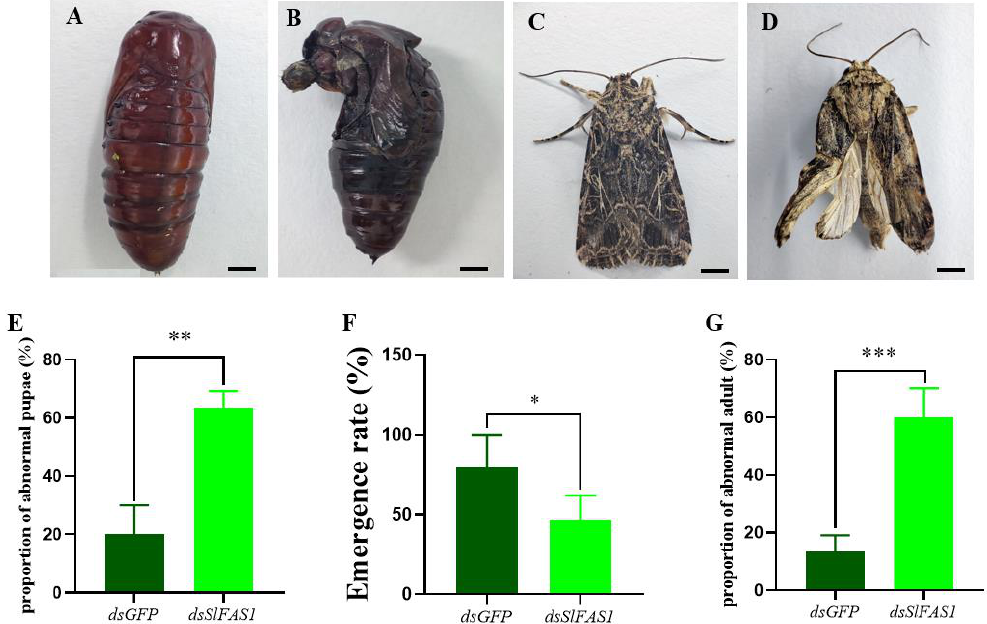
Figure 8. Morphology of pupae and adults after knocking down SlFAS1 in fifth instar S. litura . ( A ) Normal pupae after dsGFP injection. ( B ) Abnormal pupae after dsSlFAS1 injection. ( C ) Normal adults after dsGFP injection. ( D ) Abnormal adults after dsSlFAS1 injection. ( E ) Effect of silencing SlFAS1 on the proportion of abnormal pupae in S. litura . ( F ) Effect of silencing SlFAS1 on emergence rate in S. litura . ( G ) Effect of silencing SlFAS1 on the proportion of abnormal adults in S. litura . Significant differences were compared using a one-way analysis of variance (ANOVA). Significant differences were indicated by asterisks (* p < 0.05; ** p < 0.01; *** p < 0.001); scale bars in A and B: 2 mm; scale bars in C and D: 2 mm.